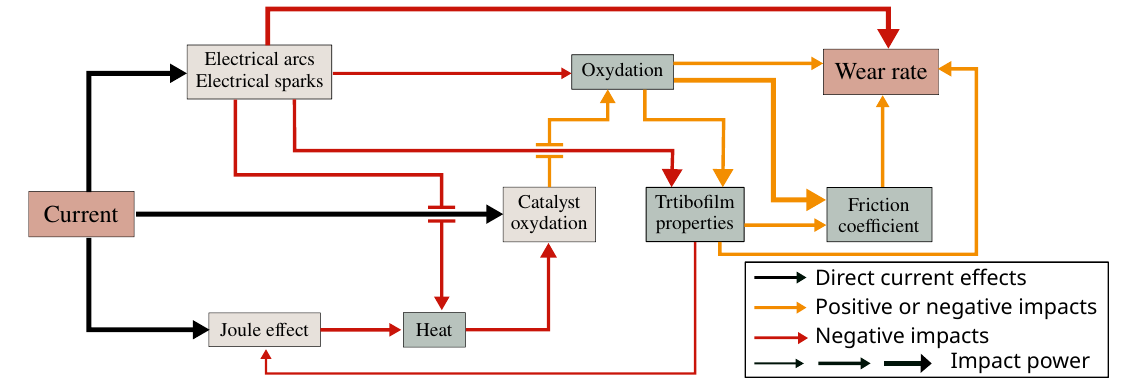
Figure 10. ( a ) Correlation between the temperature of the contact strip and the wear rate from an article by Chen G.X. [35]. ( b ) Correlation between the arc discharge energy rate and the wear rate, from an article by Mei G. [80]. ( c ) Mass loss of the carbon strip according to the variation of the current at different temperatures, from an article by Ding T. et al. [9].